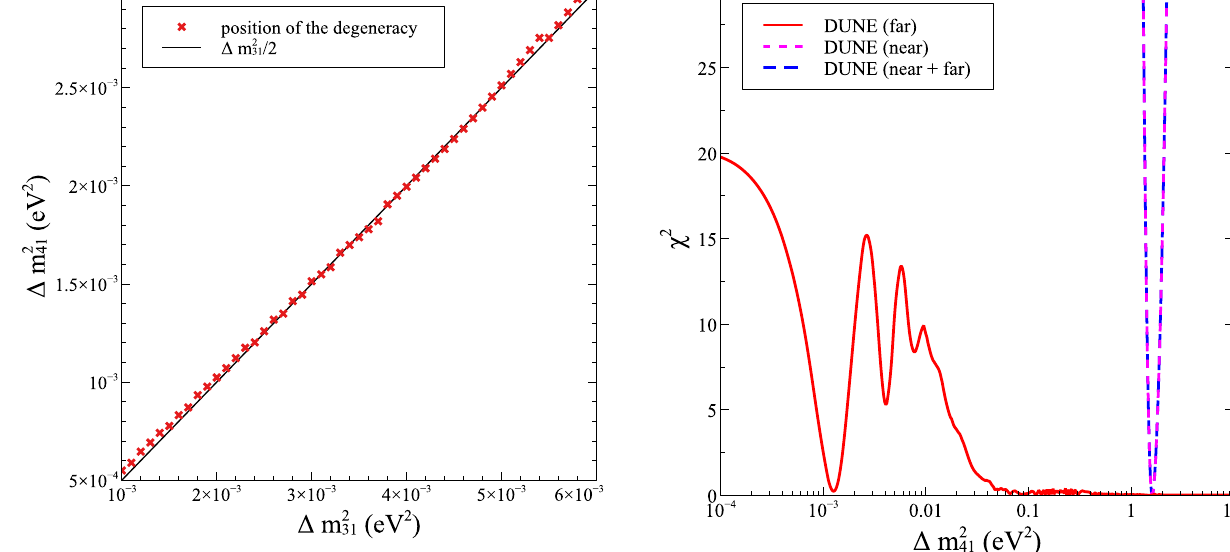
for both near and far detectors. The 41